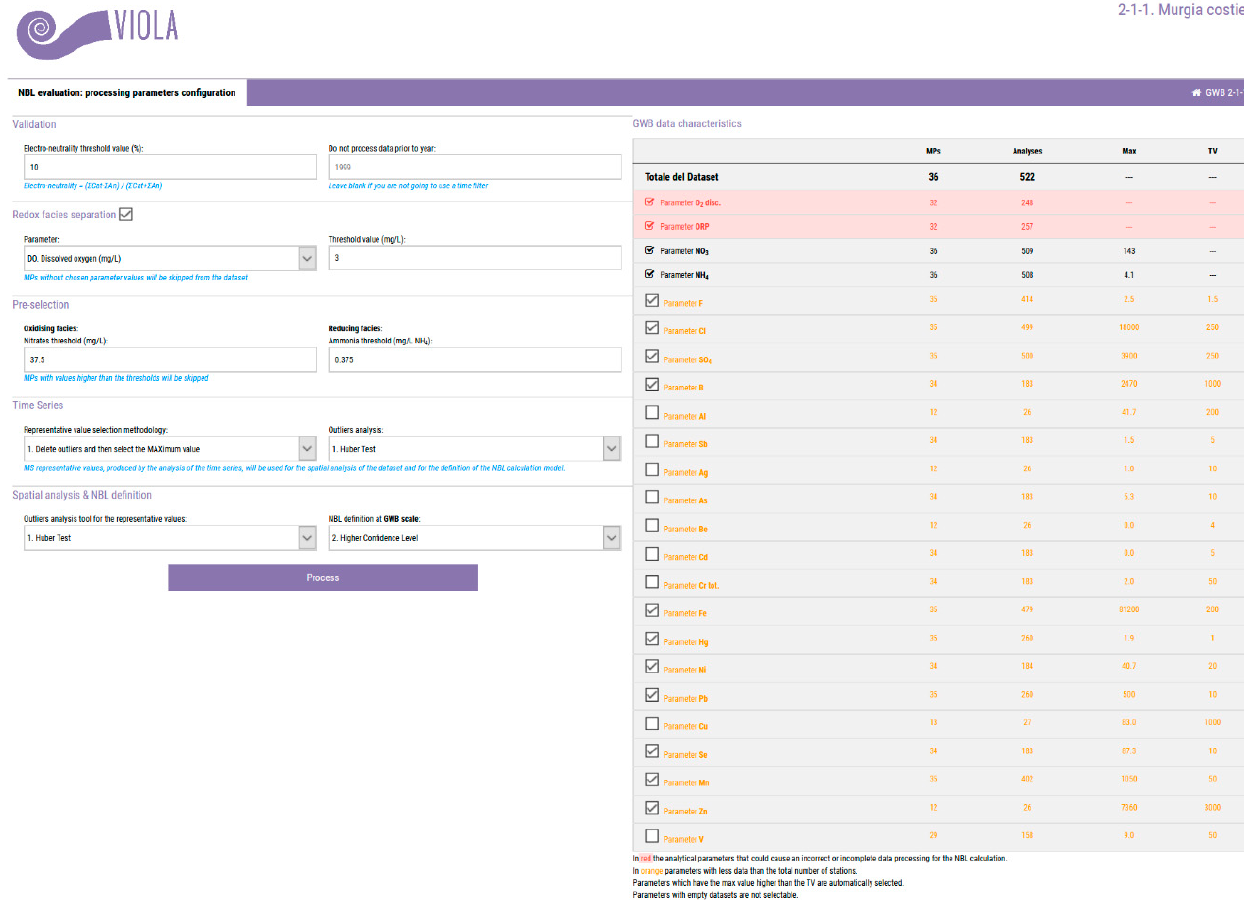
Figure 1. The page of the VIOLA Project web site where the parameters for the NBLs assessment can be configured. On the right side the procedure provides general information about the GWB analytical dataset while, on the left, it allows the settings for the NBL evaluation.